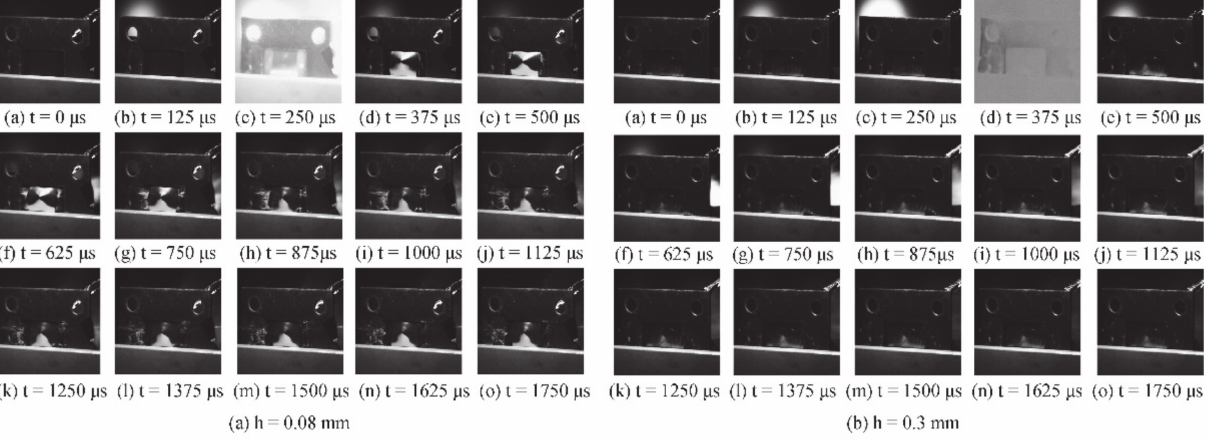
Figure 8. ( a ) Changes in the morphology of the target back at different moments when h = 0.08 mm. ( b ) Changes in the morphology of the target back at different moments when h = 0.3